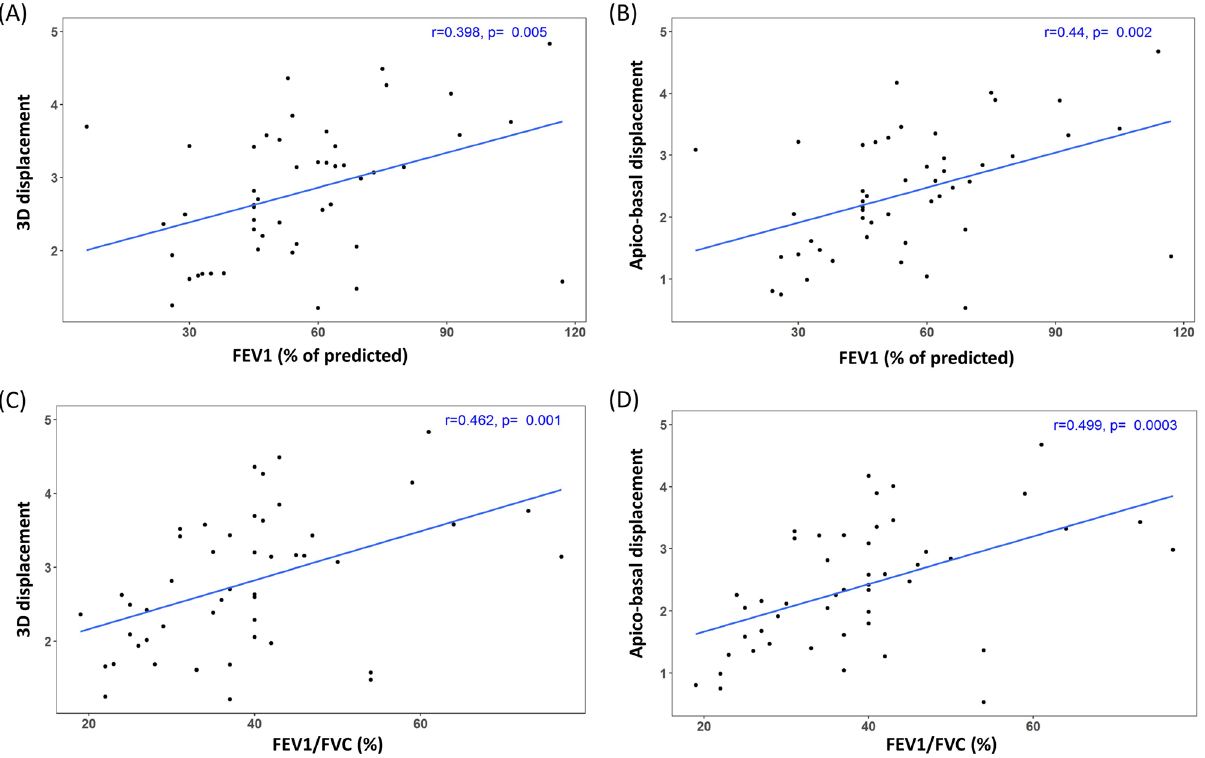
Figure 4. Correlation between pulmonary function test variables and magnitude of displacement vectors in emphysema patients. ( A , B ) Correlation between forced expiratory volume in 1 s (FEV1 [% of predicted]) and displacement of the diaphragm. ( A ) FEV1 (% of predicted) is positively correlated with 3D displacement of the diaphragm (r = 0.398, P = 0.005). ( B ) FEV1 (% of predicted) is positively correlated with apico- basal displacement of the diaphragm (r = 0.44, P = 0.002). ( C , D ) Correlation between FEV1 / forced vital capacity (FVC) (%) and displacement of the diaphragm. ( C ) FEV1/FVC (%) is positively correlated with 3D displacement of the diaphragm (r = 0.462, P = 0.001). ( D ) FEV1/FVC (%) is positively correlated with apico-basal displacement of the diaphragm (r = 0.499, P = 0.0003).